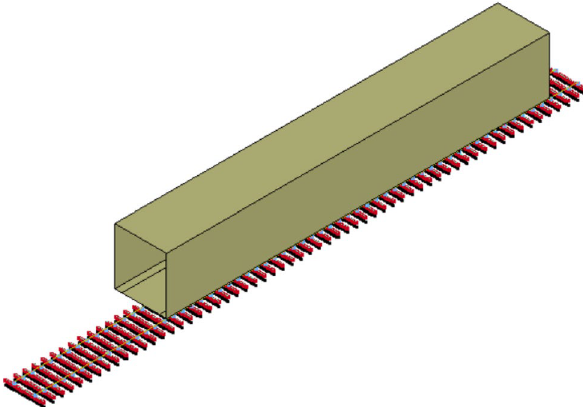
Figure 1. The 3D vehicle-slab FEM model 16 .